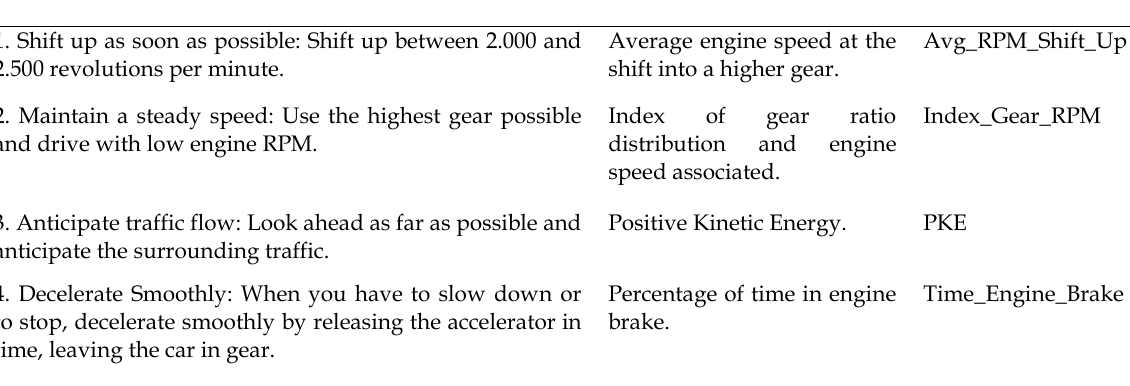
Table 1. Main rules of eco-driving and indicators